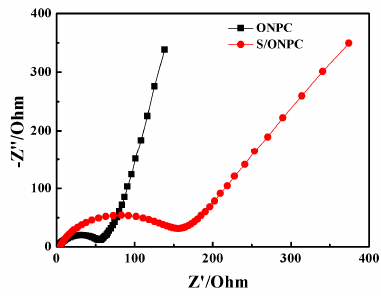
Figure 6. EIS results of ONPC and S/ONPC electrodes.